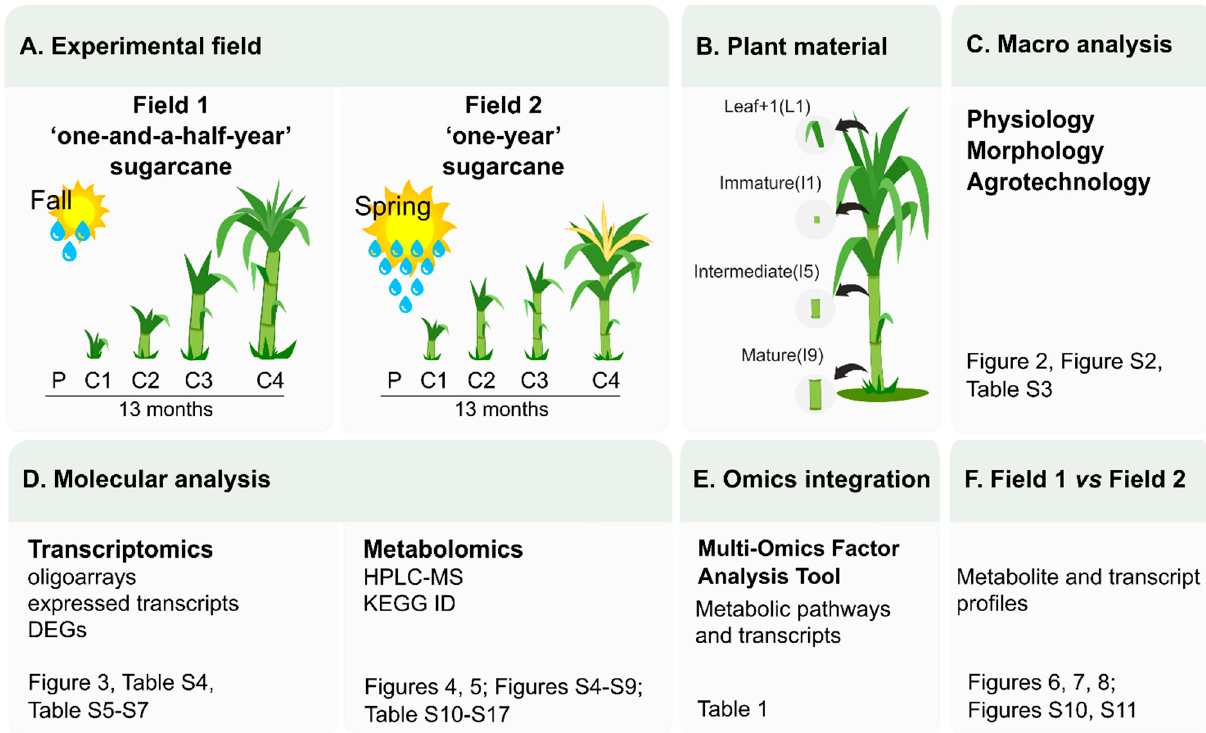
Figure 1. Experimental design and guide to datasets. ( A ) The sugarcane variety SP80-3280 was field grown under two planting seasons (Fall and Spring) with different climatic conditions and data and sample collection were done after 4 (C1), 8 (C2), 11 (C3) and 13 (C4) months after planting (P). ( B ) Plant material collected for molecular analysis: leaf +1 (L1), immature (I1), intermediate (I5) and mature internodes. A systems biology approach was taken to study the changes on ( C ) physiological, morphological, agrotechnological, ( D ) transcriptomics, and metabolomics levels. ( E ) The MOFA tool was used to point out the main metabolic pathways that were activated and altered throughout development. ( F ) Finally, comparisons between the results from Field 1 and Field 2 were done in each sugarcane tissue studied.